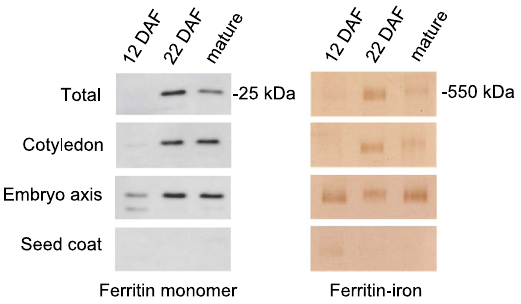
Figure 2. Ferritin levels in cotyledons, embryo axis and seed coat. Protein extracts (20 µ g) from total pea seeds (JI1194), cotyledons, embryo axis and seed coat at three stages of development were separated by SDS- PAGE for immunoblot analysis (left panels) or by native PAGE for iron staining (right panels). The results are representative of 3 independent biological replicates, and each sample was prepared from 2–3 seeds or